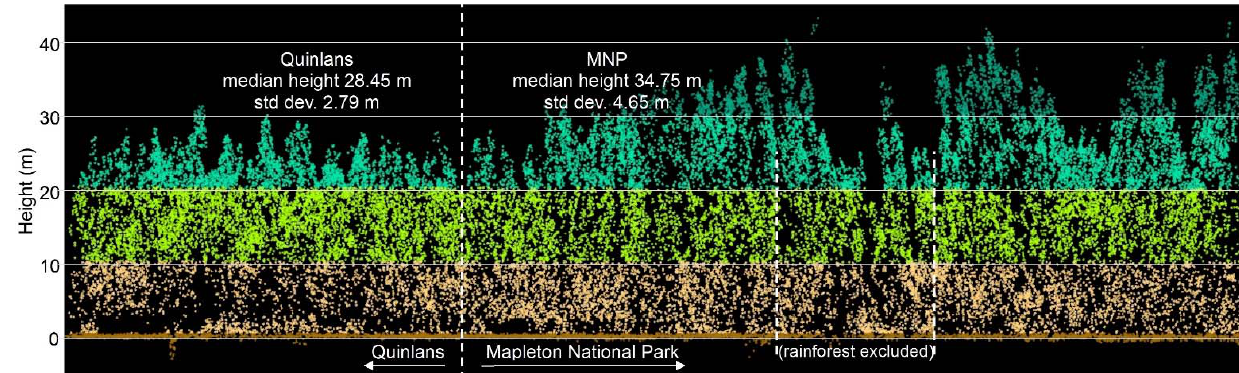
Figure 8. ALS profile (southwest to northeast) across the Sunshine Coast local study site illustrating the forest canopy height differences between the regenerating forest (Quinlans) and mature/old growth forest (Mapleton National Park). Rainforest area is excluded from our research. Height information from Table 8. Transect length 1300 m, vertical exaggeration 7 × .